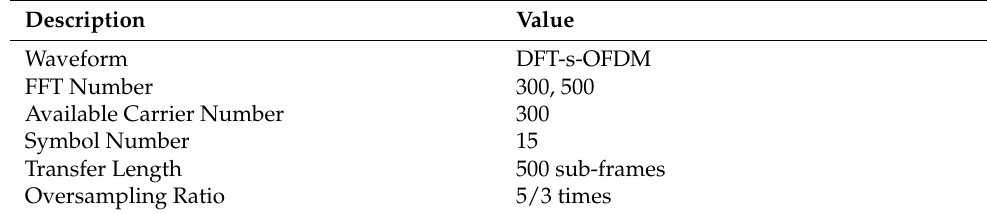
Table 4. Simulation parameter.